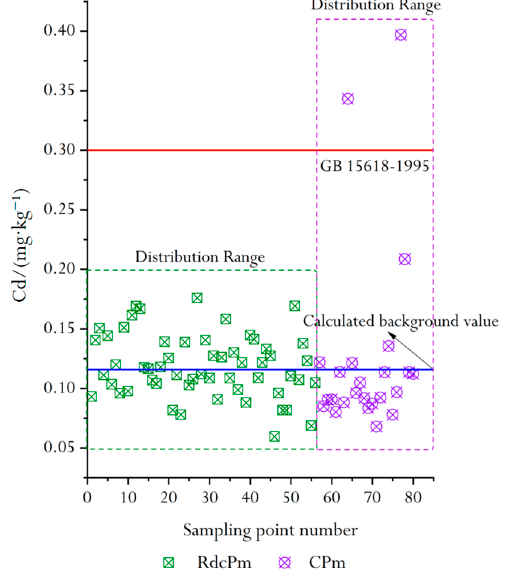
Figure 6. Scatter plot of Cd concentration in two soil parent materials.